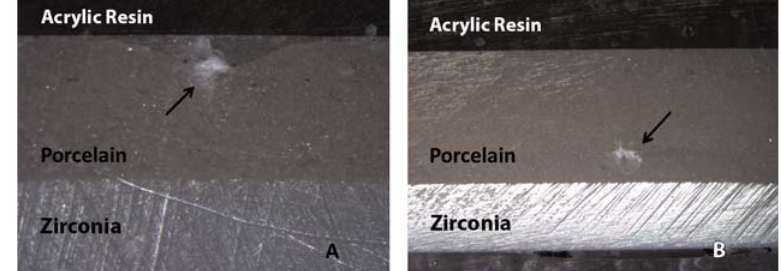
Figure 2- Vickers indentation. Far (A) and close to the interface (B) Table 2- Flexural strengths (MPa) and types of failures